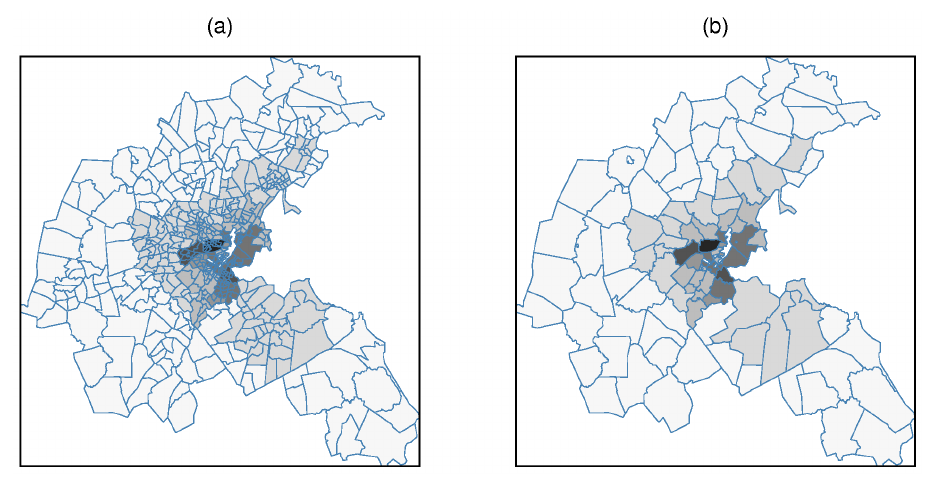
Figure 2: NOX values in parts per 10 million shown using the same class intervals and color fill as Figure 1 for two sets of observation units: (a): 506 census tracts and (b): 96 approximate TASSIM